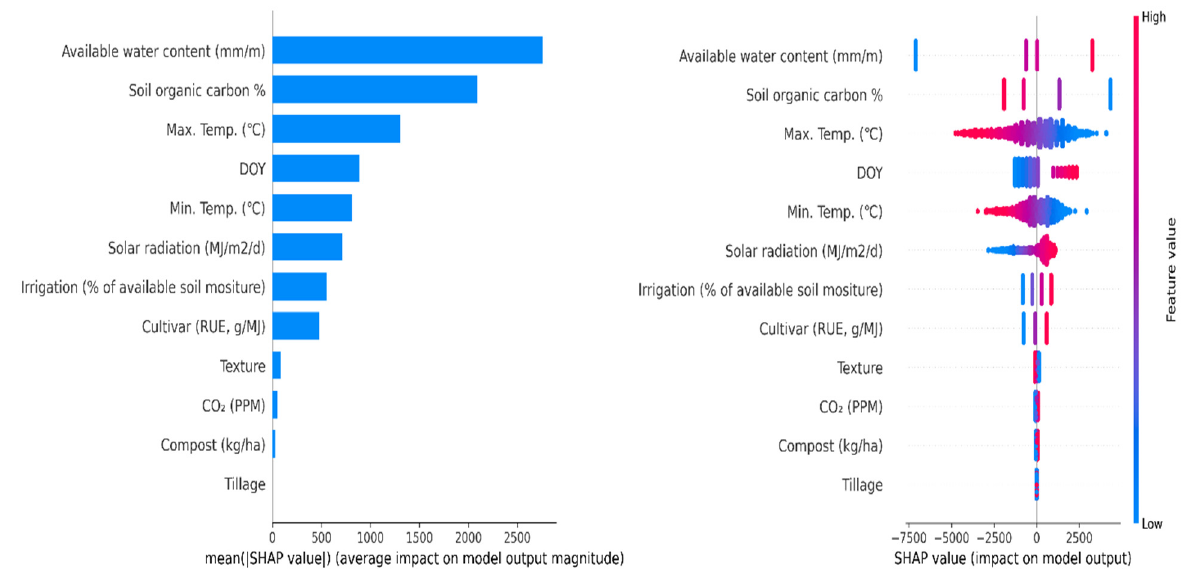
Figure 5. Feature importance for grain yield (kg ha − 1 ) based on SHAP-values for the lasso regression model. On the left , the mean absolute SHAP-values are depicted to illustrate global feature im- portance. On the right , the local explanation summary shows the direction of the relationship be- tween a feature and the model output. Positive SHAP-values are indicative of increasing grain yield, whereas negative SHAP-values are indicative of decreasing grain yield.